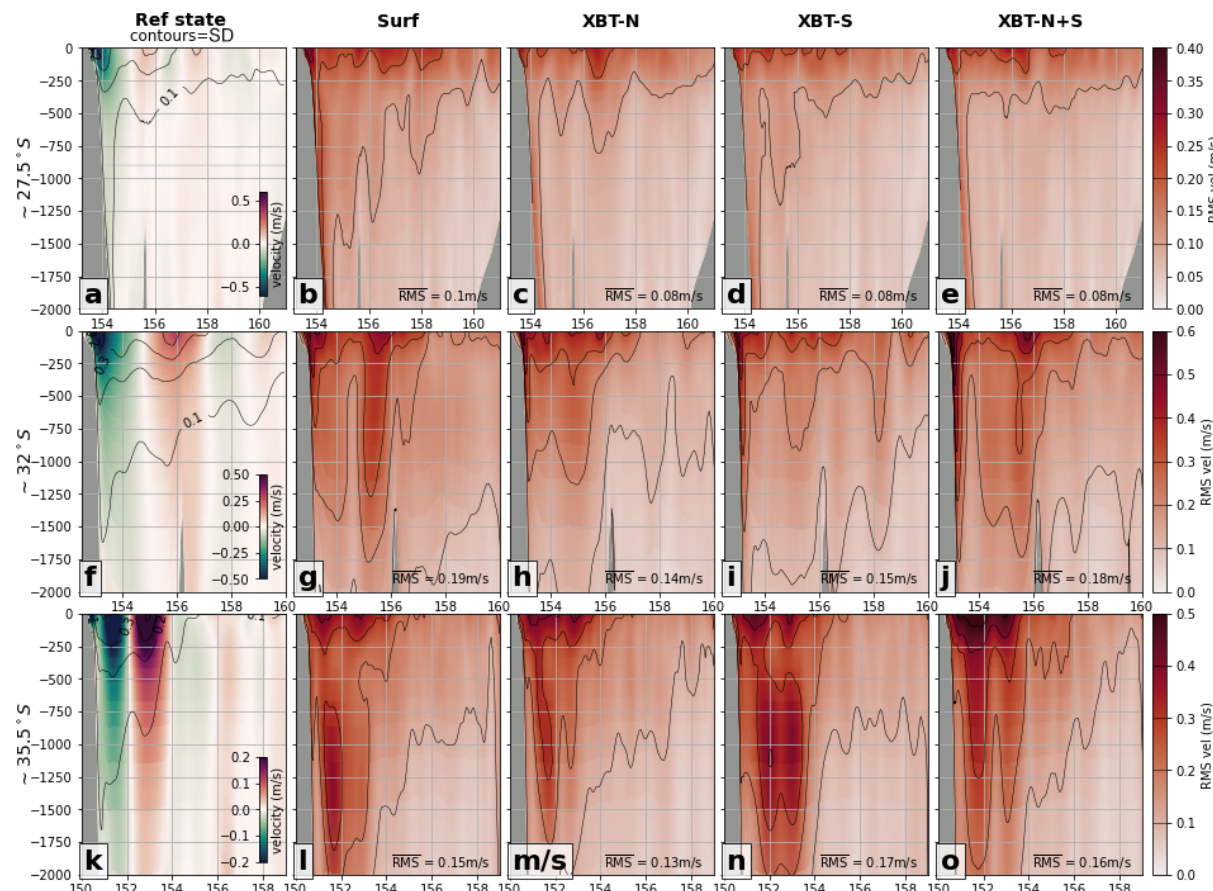
Figure 6. Vertical cross-sections of meridional (north/south) velocity at key transects (first row) ∼ 27.5 ◦ S, (second row) ∼ 32 ◦ S, and (third row) ∼ 35.5 ◦ S are shown for each experiment. (a) The time-mean velocity (northwards–positive) in the reference state, with contours of standard deviation in the reference state velocity. The rms error between the reference state and the OSSEs (b) surf, (c) XBT-N, (d) XBT-S, and (e) XBT-N+ is shown at the transect ∼ 27.5 ◦ S. The second row (f–j) shows the same fields as the first row, but for the second transect at ∼ 32 ◦ S, while the third row (k–o) shows the same fields but for the third transect at ∼ 35.5 ◦ S. In reference state panels, contours are the standard deviation in the respective field while in all OSSE panels, the contours are of RMSE. Contour intervals are shown as a line in the RMSE colour bar. The depth-averaged RMSE of the region shown in each panel is included in the bottom